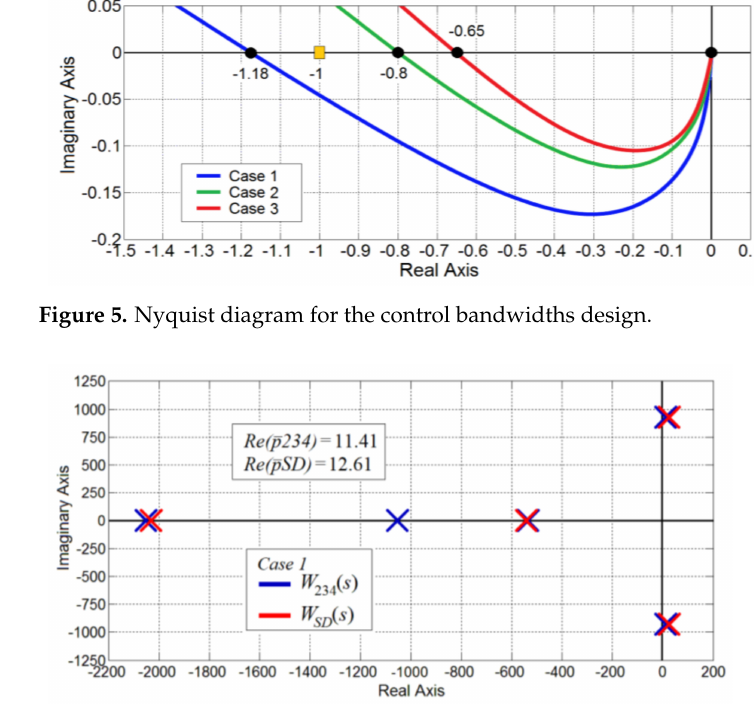
Figure 6. System poles, transfer function W ( s ) (Case 1).